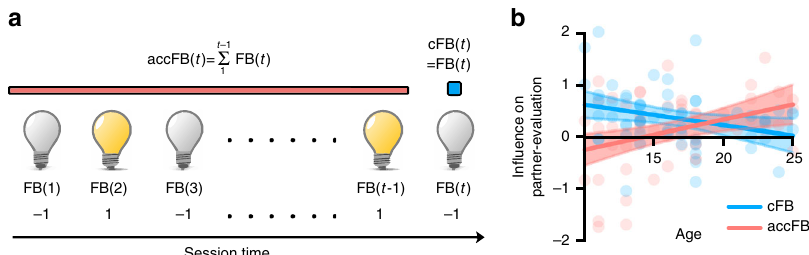
Fig. 2 Developmental trajectories of the cFB and accFB in fl uence. a Schematic illustration of current feedback (cFB) and accumulated feedback (accFB) parameter. Lighted and unlighted bulbs describe the received feedback value of each trial. cFB depicted by blue dot is feedback value of current trial. accFB, depicted by the red line, is accumulated feedback value summed from the fi rst trial to the immediately preceding trial. b Interaction between feedback type and age on contribution to partner-evaluation. Blue circles, line and band indicate individuals ’ cFB parameter estimates, the best fi tted line and 95% con fi dence interval band, respectively. Red circles, line, and band indicate individuals ’ accFB parameter estimates, best fi tted line and 95% con fi dence interval band,